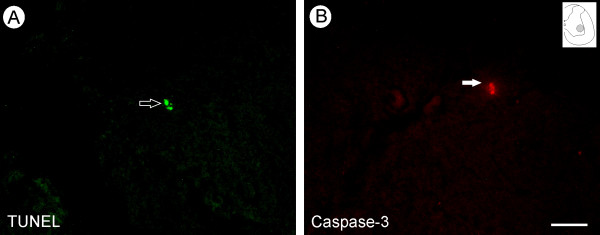
Absence of IFNγ results in neuronal death. (A) TUNEL labeled neuron (arrow) within the motor nucleus indicates the development of apoptosis. (B) Representative immunofluorescence image showing a caspase-3 positive motoneuron in an IFNγ-KO unlesioned mouse. Scale bar 50μm.